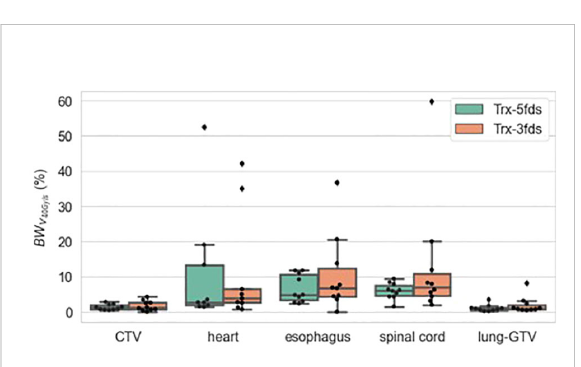
FIGURE 9 V 40Gy/s robustness of 10 patients of different RT structures. The dots represent each of the 10 patients, the line inside the box represents the mean value, and the error bars outside and the box represent the 25-75 th percentile of the scattered